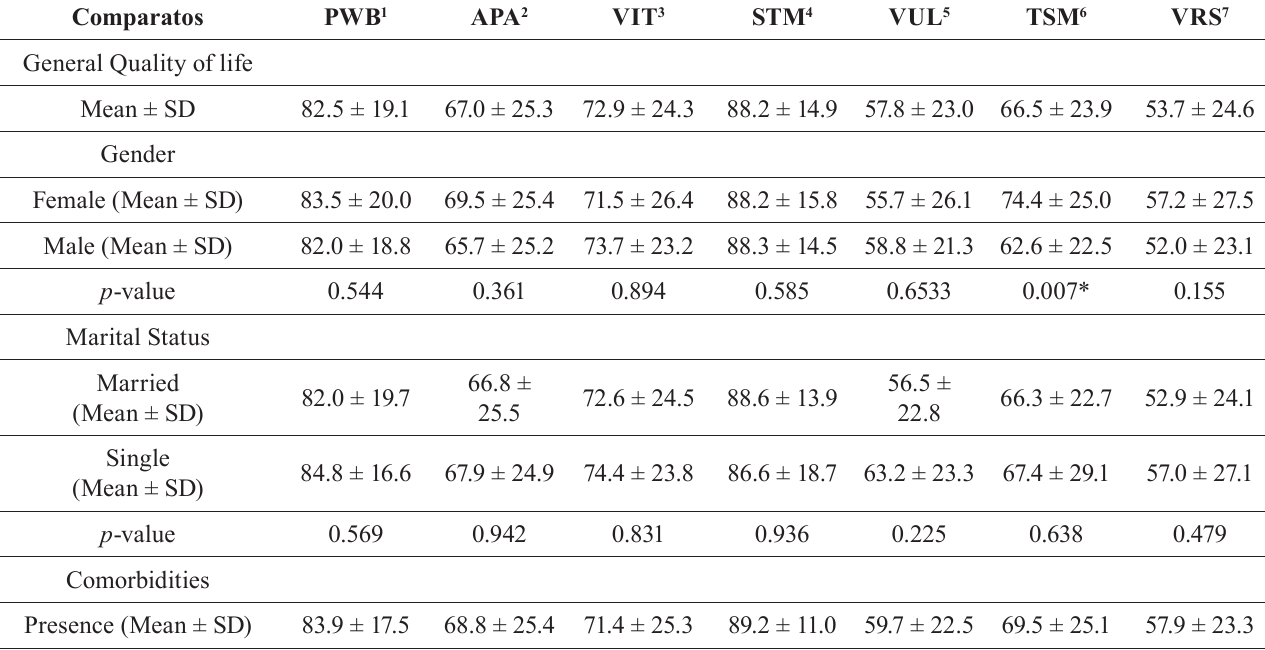
TABLE V - R esults of the analysis of the quality of life domains of the 124 patients with HBC and the co-variables gender, marital status, comorbidities, age and time of treatment